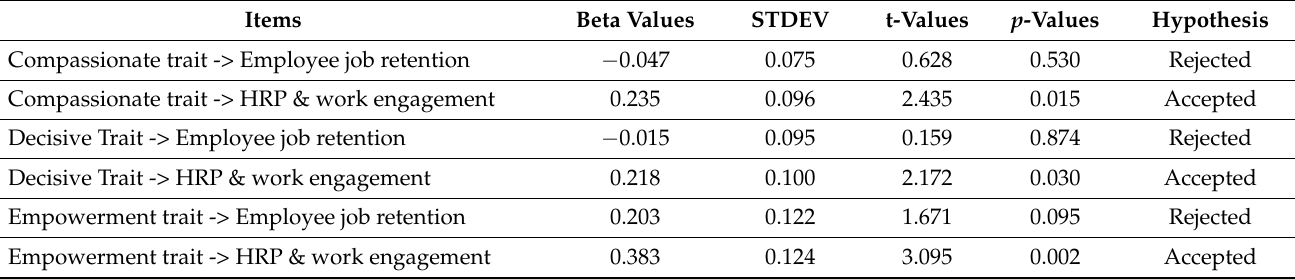
Table 6. Mean, STDEV, t-Values, and p